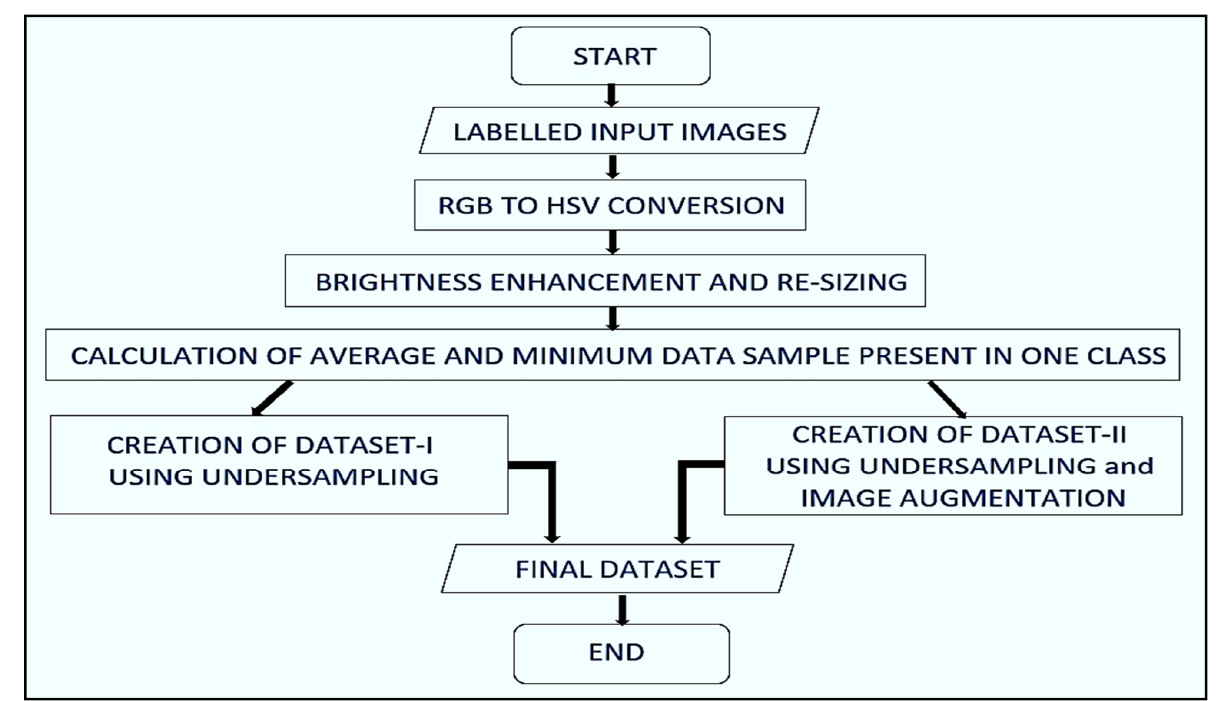
6 Figure 4. Sample of images present in the dataset ( a ) Healthy mango leaf, ( b ) Infected mango leaf, ( c ) Image after enhancing the brightness of 4 ( a ) image, ( d ) artificially generated mango leaf. 3.3. Organization of the Dataset for Training The dataset was organised as two test cases, as shown in Figure 5. Each of the healthy and infected sets of data of different plant species were considered a class in this experi-